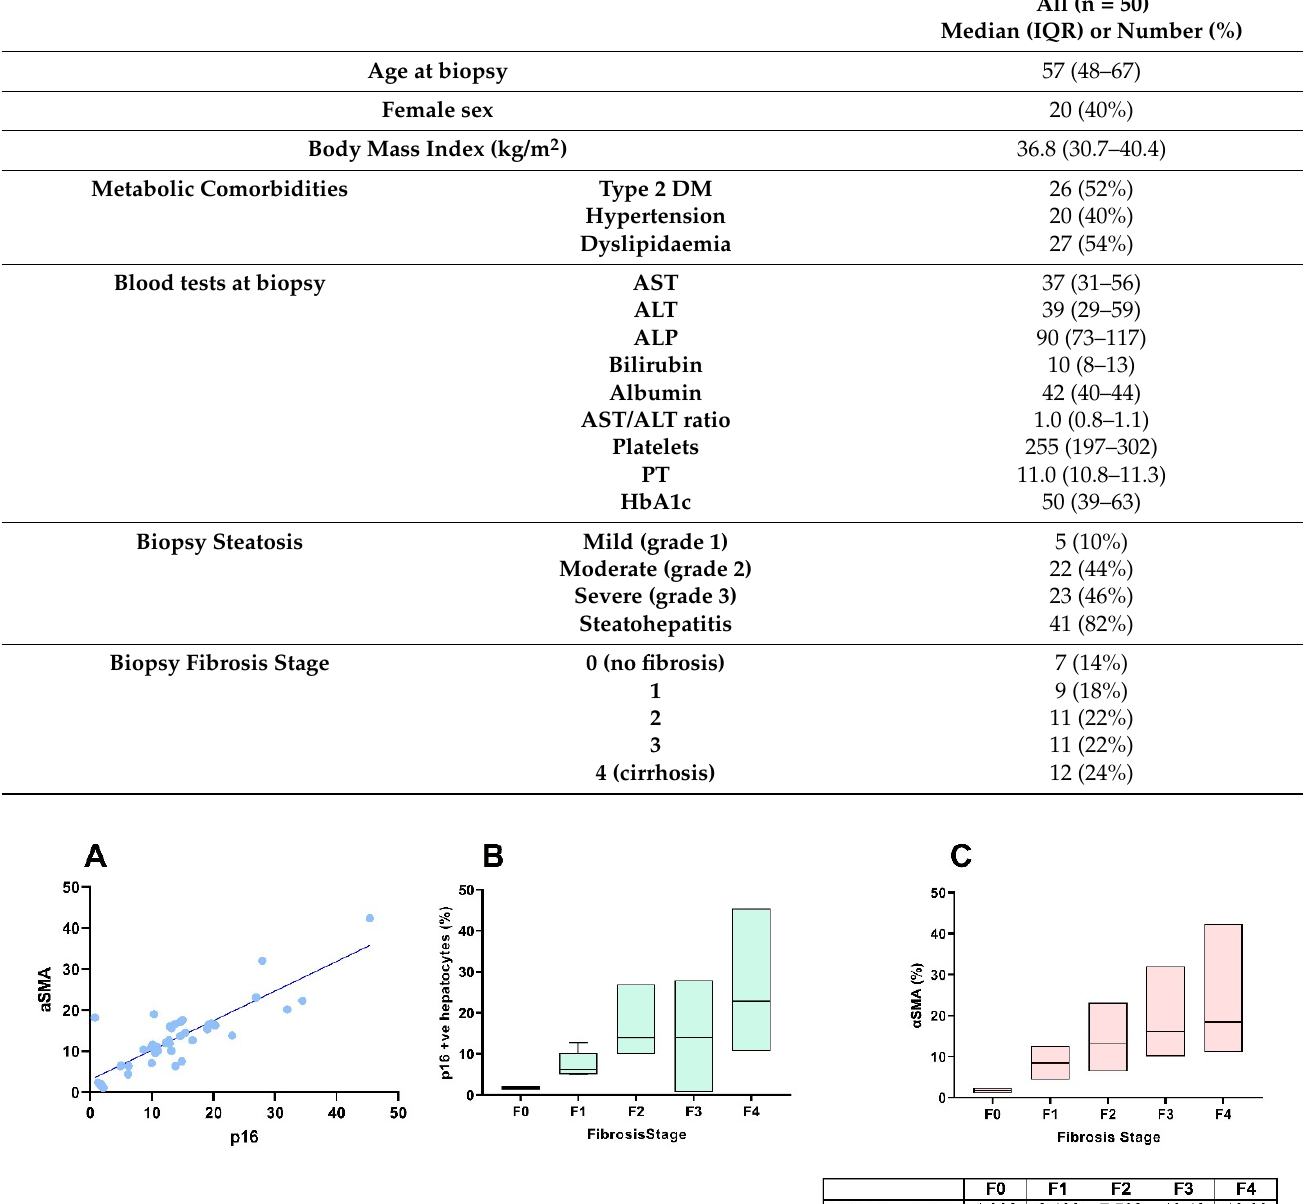
Demographic and clinical characteristics of patients with non-alcoholic fatty liver disease (NAFLD).